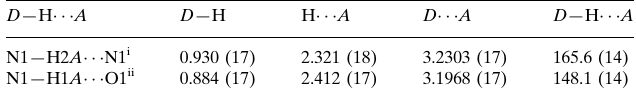
Hydrogen-bond geometry (A˚ , (cid:1)